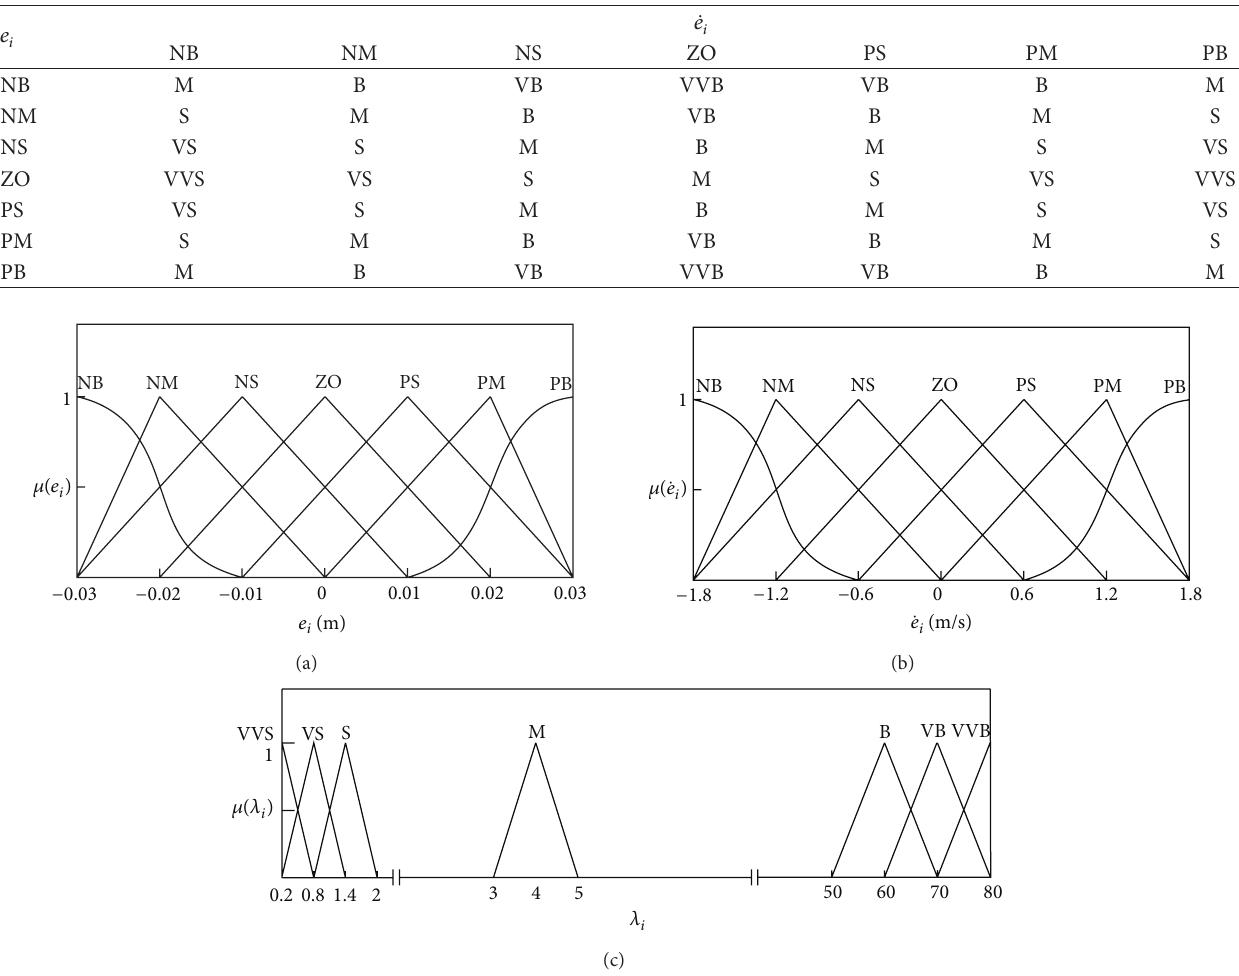
Table 1: Fuzzy associative memory (FAM) table for switching gain 𝜆 𝑖 .